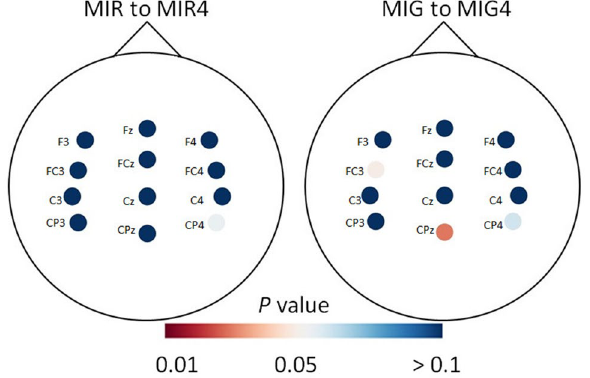
Figure 7. Heatmap depicting the P values of pairwise comparison for ERP latency between measurement sessions (before and after training) for motor imagery of reaching (MIR to MIR4) and motor imagery of grasping (MIG to